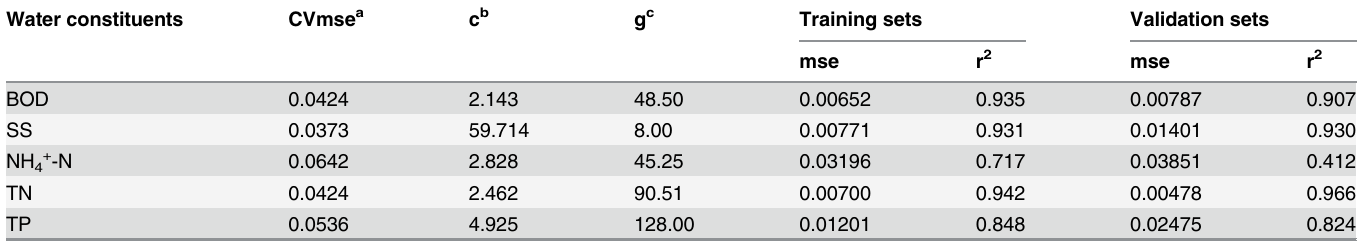
Table 2. Optimized support vector regression (SVR) models for effluent prediction in terms of BOD, SS, NH 4+ -N, TN and TP (all with microbial com- munity compositions as inputs). Water